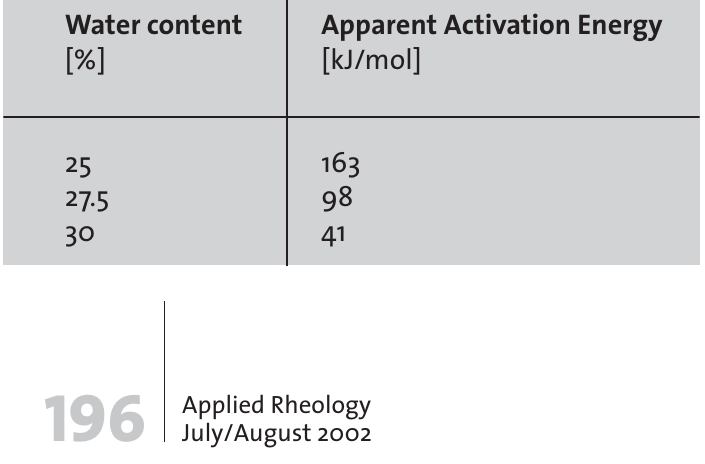
Table 1: Apparent activation energy at 107 °C.